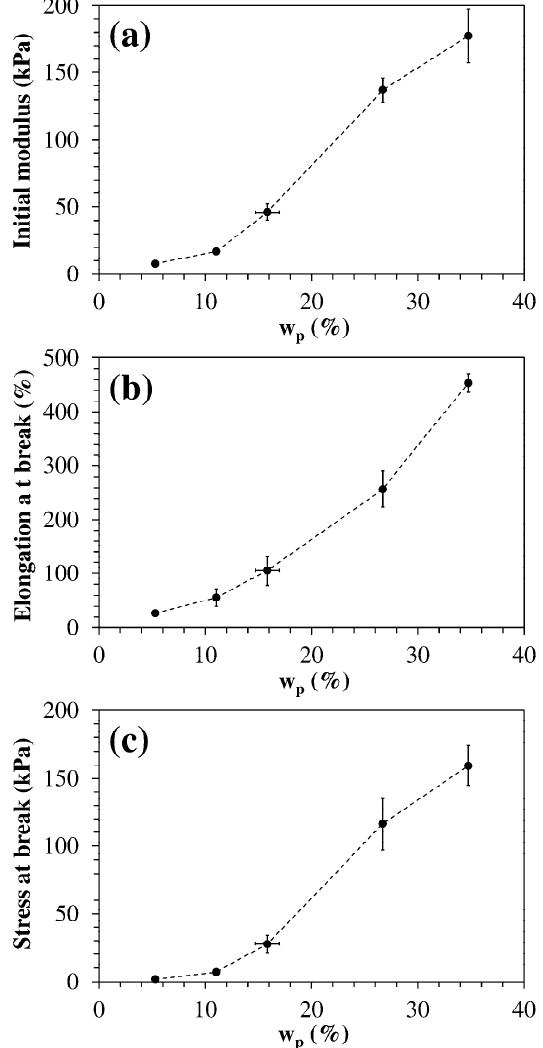
Figure 12. Variation of ( a ) initial modulus, ( b ) elongation at break, and ( c ) stress at break with the polymer weight content (f JD400 = 0.40, f ODA from 0 to 1). Each datum represents the average of four